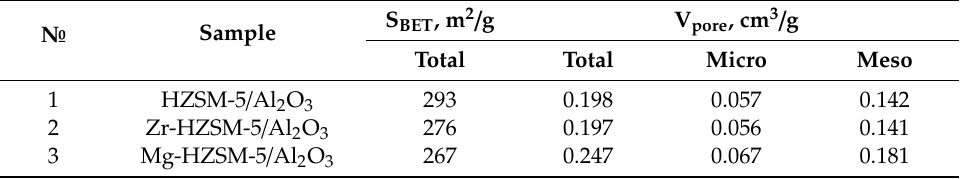
Table 2. Textural properties of the HZSM-5 / Al 2 O 3 , Zr-, and Mg- modified samples